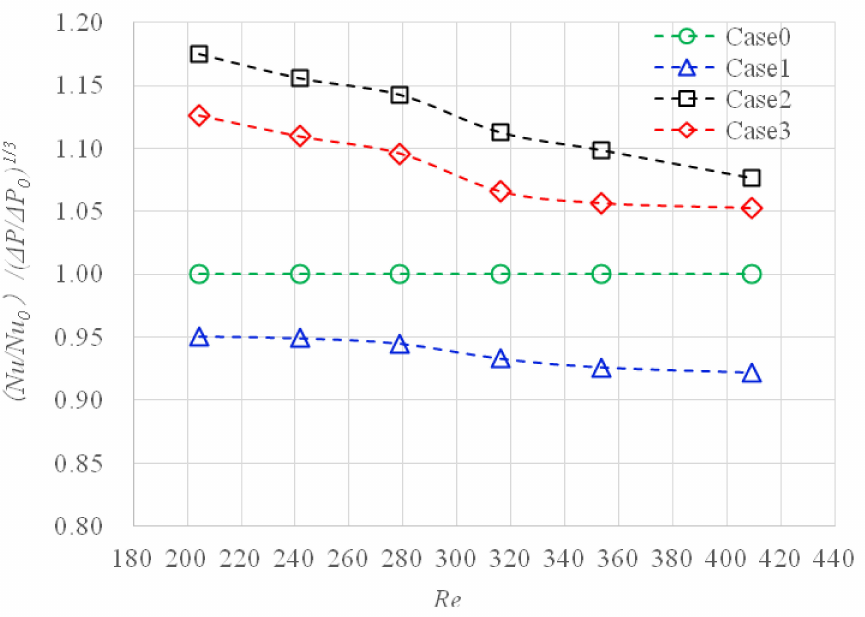
Figure 12. Relationship between thermal performance factor and Reynolds